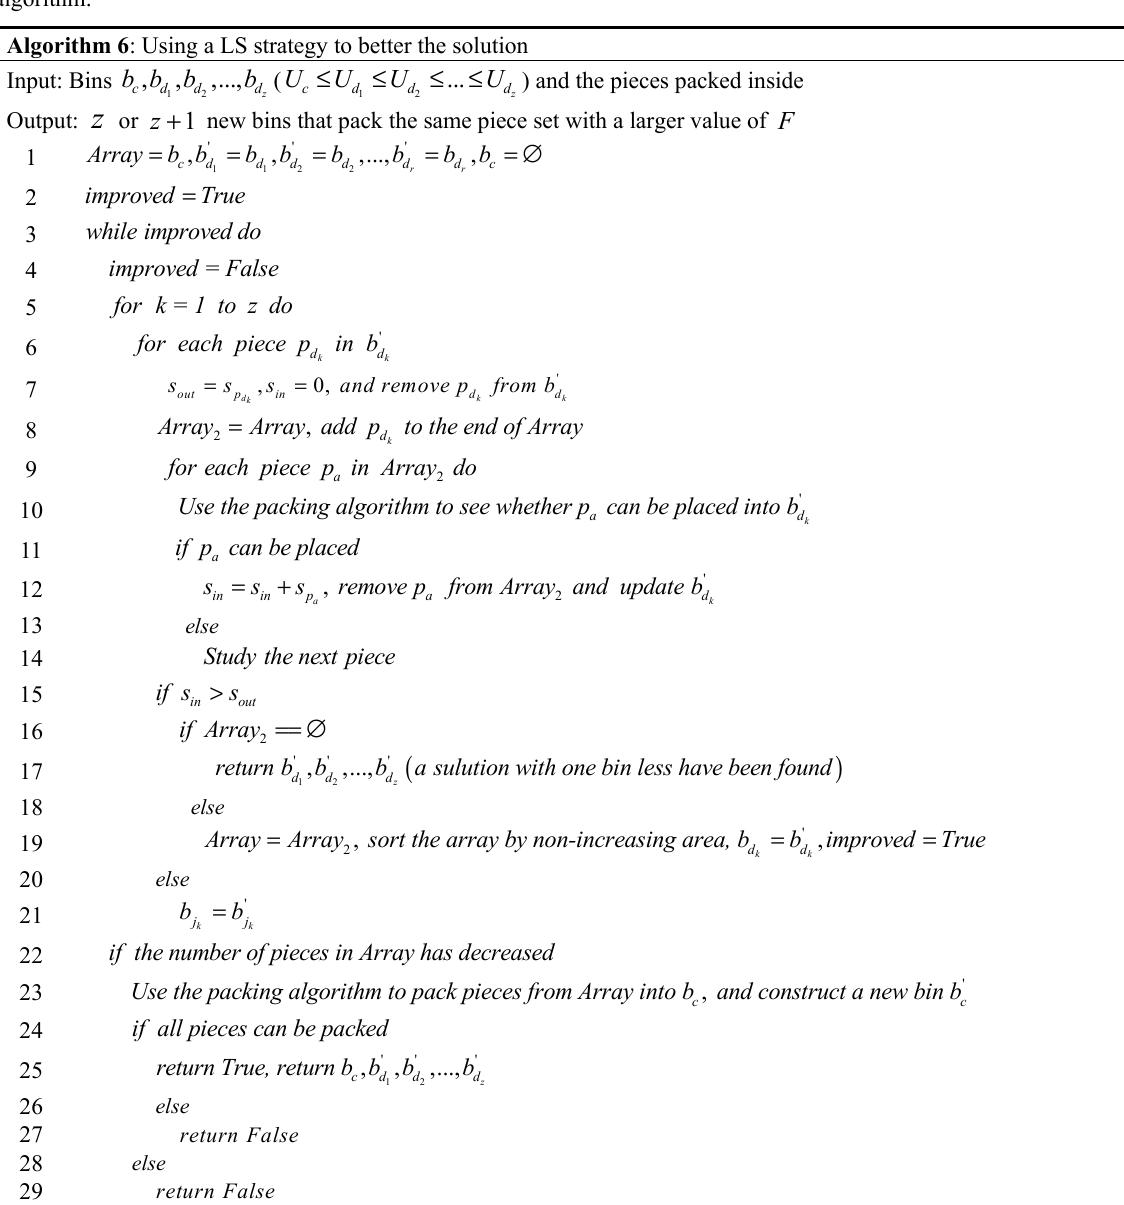
Algorithm 6 : Using a LS strategy to better the